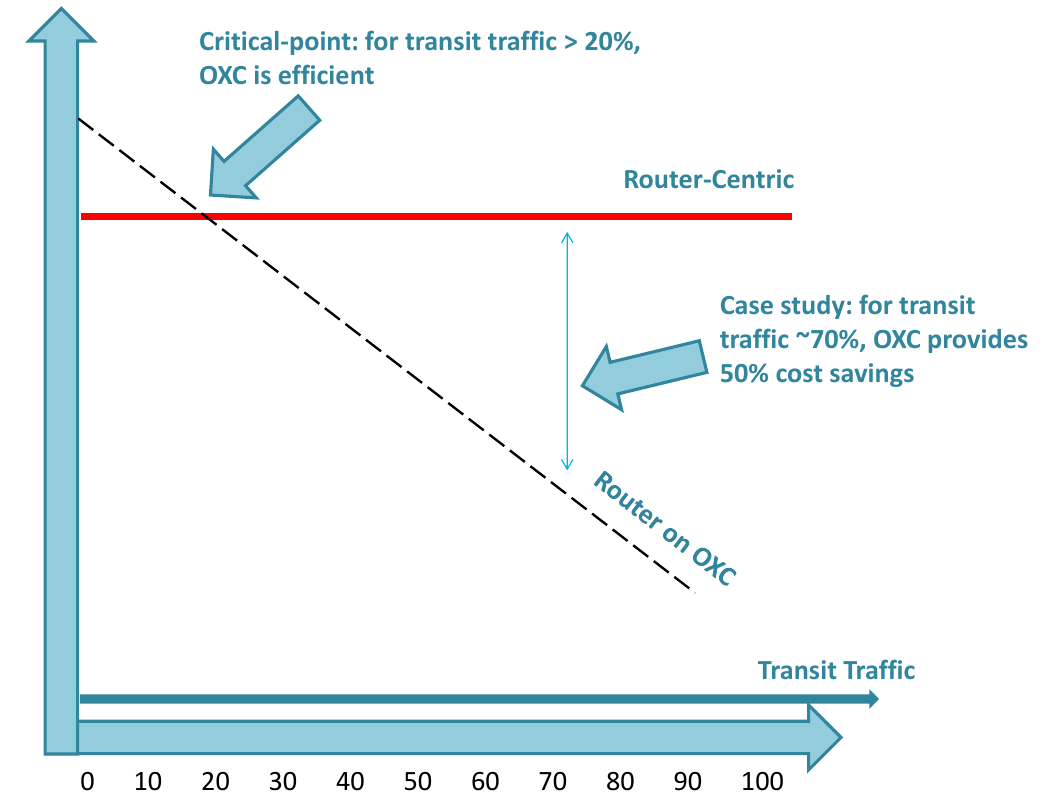
Figure 25. Improvement of performance versus transit traffic.